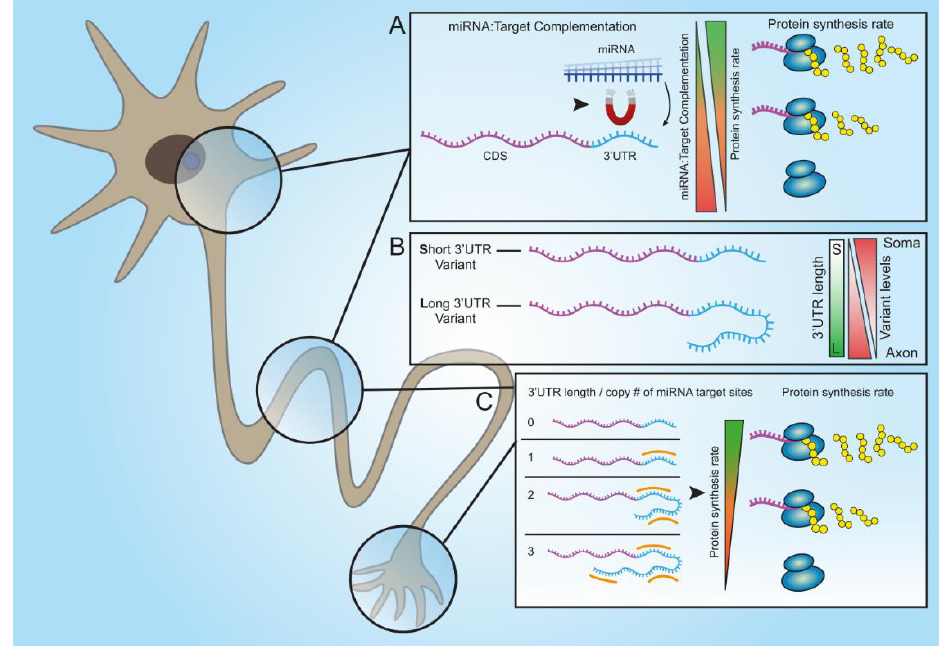
Figure 7. A model of suggested pathways for miRNA-based post-transcriptional regulation at subcellular resolution within motor neuron axons. ( A ) The efficacy of miRNA silencing in cells is determined by the target sequence complementation of the miRNA. Higher complementation (e.g., 8mer) yields stronger target silencing, which results in slower protein synthesis. ( B ) Axonal mRNA transcripts contain longer 3 (cid:48) UTR than do their cell-body variants. ( C ) The long 3 (cid:48) UTRs of axonal transcripts contain multiple miRNA binding site repeats for specific miRNA, which can differentially regulate their subcellular translation. A high repeat number correlates with a lower rate of target